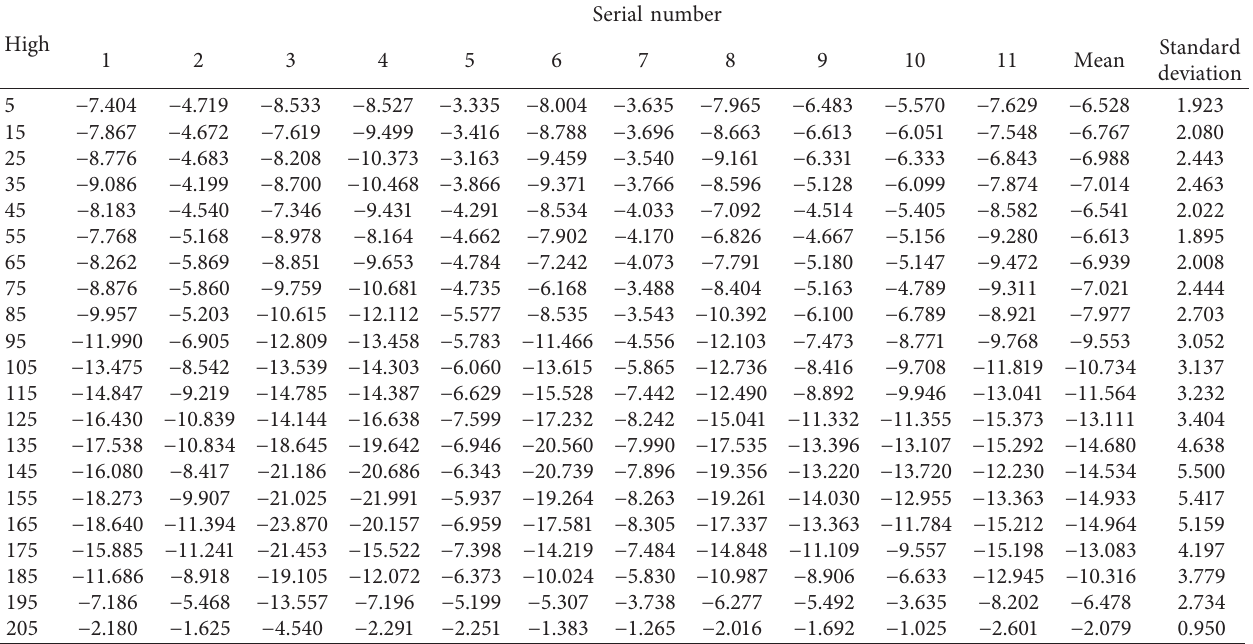
Table 12: Maximum earthquake tensile stresses of the 210m high chimney ignoring vertical eccentricities.